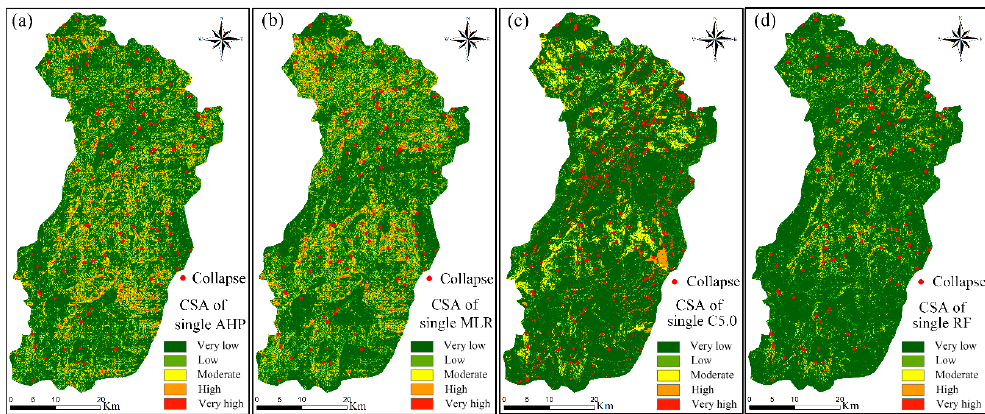
Figure 12. Collapse susceptibility maps produced by single data-based models considering original environmental factors as model input variables: ( a ) CSA of single AHP, ( b ) CSA of single MLR, ( c ) CSA of single C5.0, ( d ) CSA of single RF model.